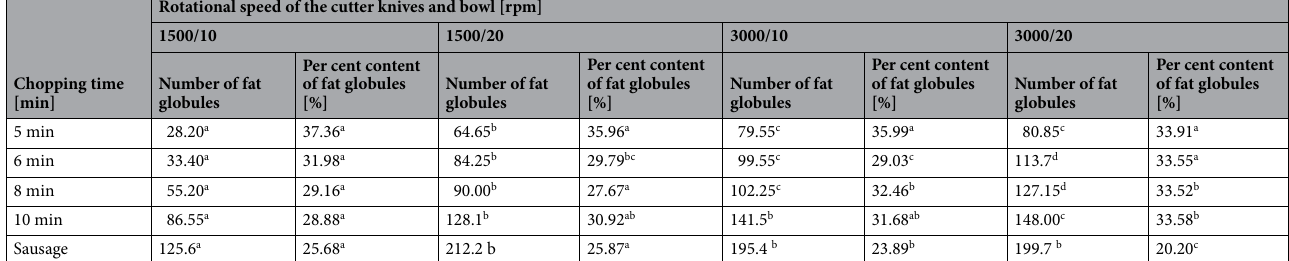
Table 3. The amount of fat particles and their percentage in the image field under analysis vs the chopping time and the rotational speed of the cutter knives and bowl (1500/10, 1500/20, 3000/10 and 3000/20 rpm). The means in the rows which are denoted by the letters a, b, c and d differ statistically significantly at p ≤ 0.05.